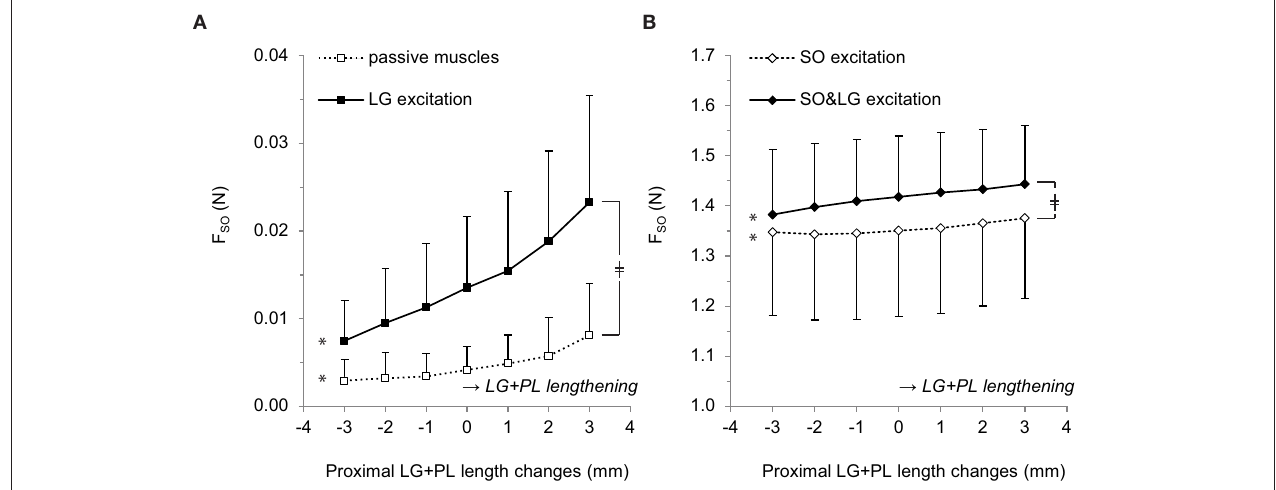
FIGURE 2 | Effects of LG + PL length changes on forces exerted at the distal tendon of SO. (A) Distal SO tendon forces for passive muscles ( (cid:3) ) and for active LG only ( (cid:4) ). (B) Distal SO tendon forces for active SO only ( ♦ ) and for active SO and LG muscles ( (cid:7) ). Means ± s.d. are shown ( n = 5). Significant effects of LG + PL length are indicated as * p ≤ 0.05. Significant interaction effects between muscle excitation and LG + PL length are indicated as ‡ p ≤ 0.05.